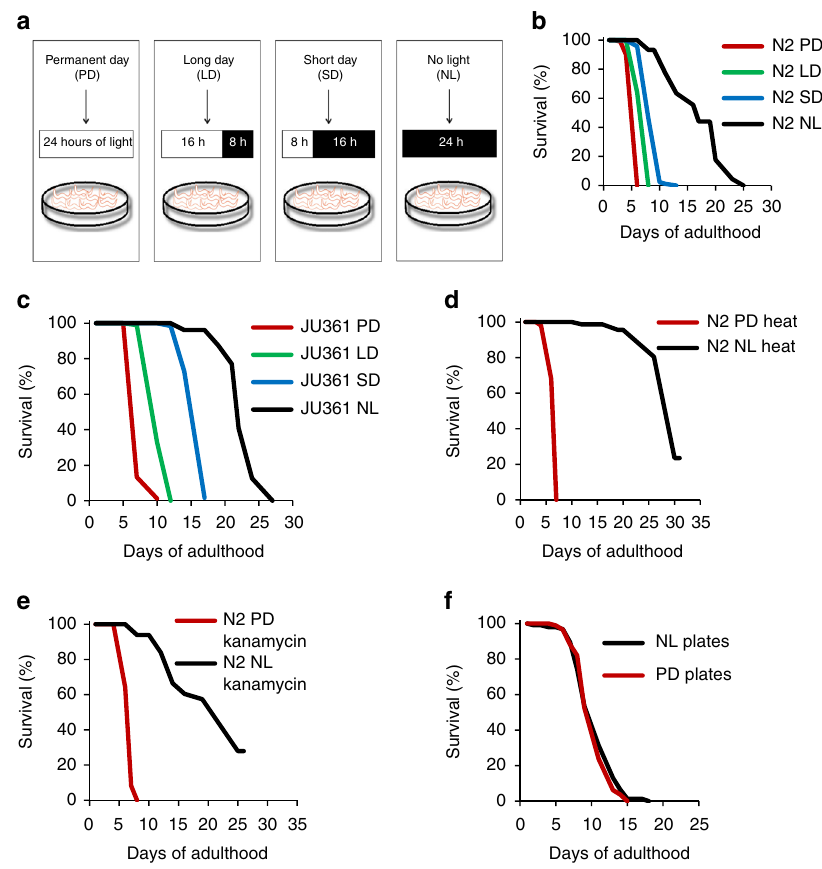
Fig. 1 Daily light exposure decreases C. elegans lifespan. a Experimental setup for exposing worms to different photoperiods with the amount of light indicated in the white box and the amount of darkness indicated in the black box for each condition. b Lifespan of N2 worms and ( c ) of the JU361 wild isolate under the four different photoperiods. d Lifespan of N2 worms under PD or NL conditions with heat-inactivated bacteria as the source of food or, ( e ), antibiotic-lyzed bacteria as the source of food. f Lifespan of N2 worms kept in NL conditions after having been placed from D1 adult on plates previously exposed to PD or NL conditions. Worms were transferred every 1 – 2 days until the end of their